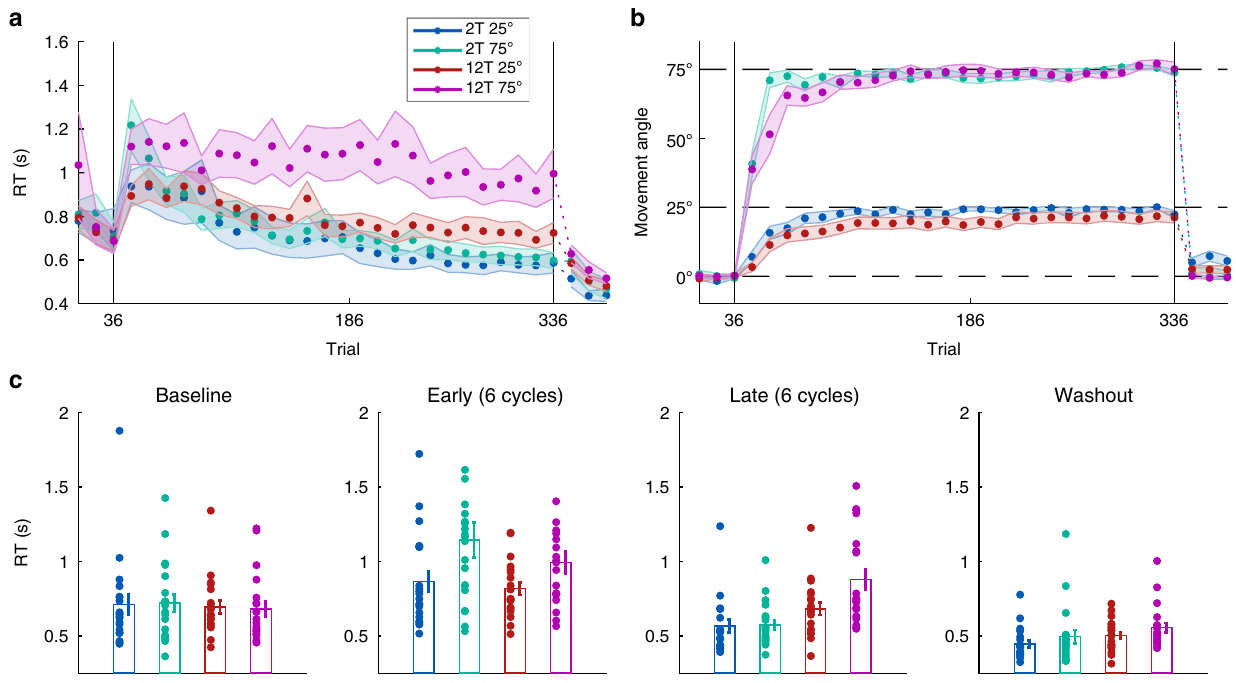
Fig. 2 Experiment 1 results. a Time course of mean RTs, averaged over 2-trial and 12-trial cycles in the 2T and 12T groups ( n = 80). Vertical lines delineate the task block (baseline, rotation, and washout). b Movement angle across the groups, averaged over 12-trial bins. c Mean of median RTs averaged over the cycles of trials in the beginning (early) and end (late) of learning, and the full baseline and washout blocks (see Methods). Error bars represent 1